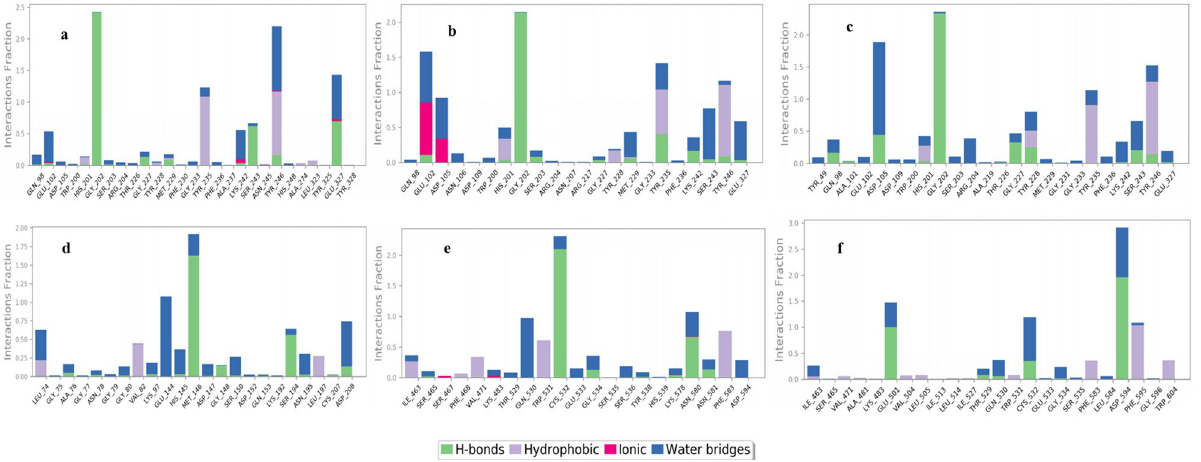
Figure 5. Protein–Ligand (P–L) interaction histograms of the six top-scored complexes, ( a – f ) [(3L3M- valganciclovir ( a ), 3L3M-ganciclovir ( b ), 3L3M-penciclovir ( c ), 4U80-entecavir ( d ), 3OG7-entecavir ( e ) and 5VAM-valganciclovir ( f )].